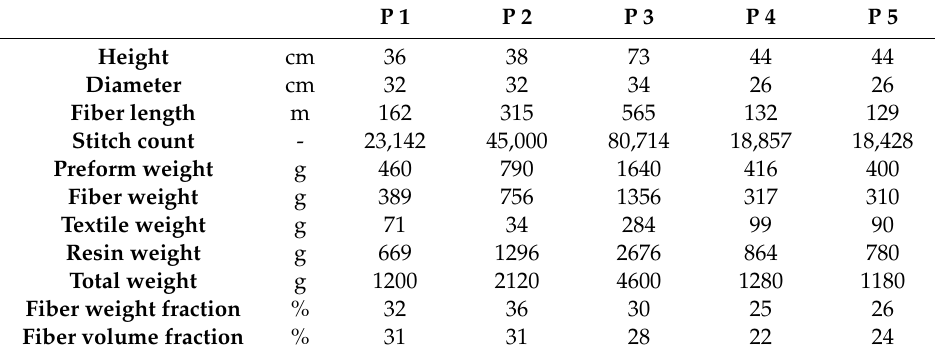
Table 1. Quantitative comparison of the five prototypes.